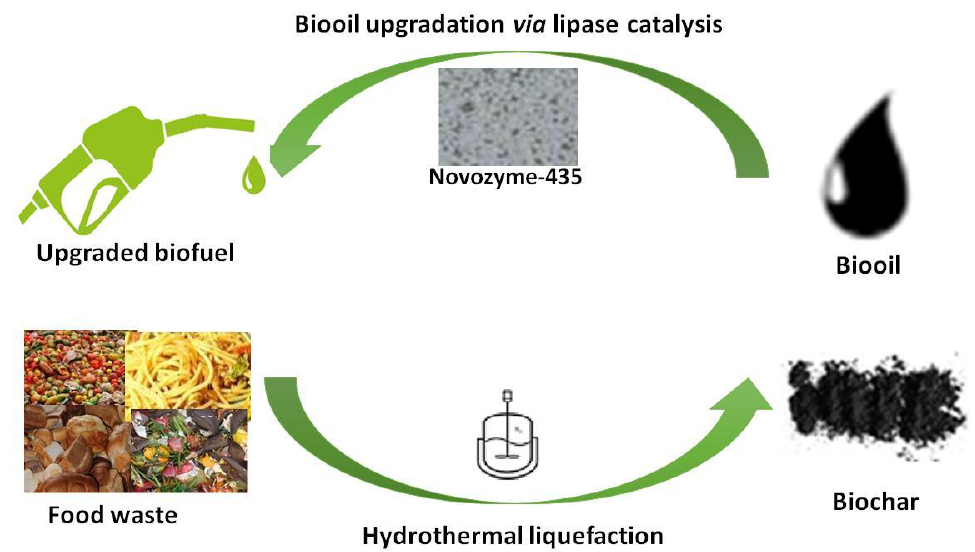
Figure 14. Lipase-catalyzed upgradation of bio-oil to obtain better quality liquid fuel.